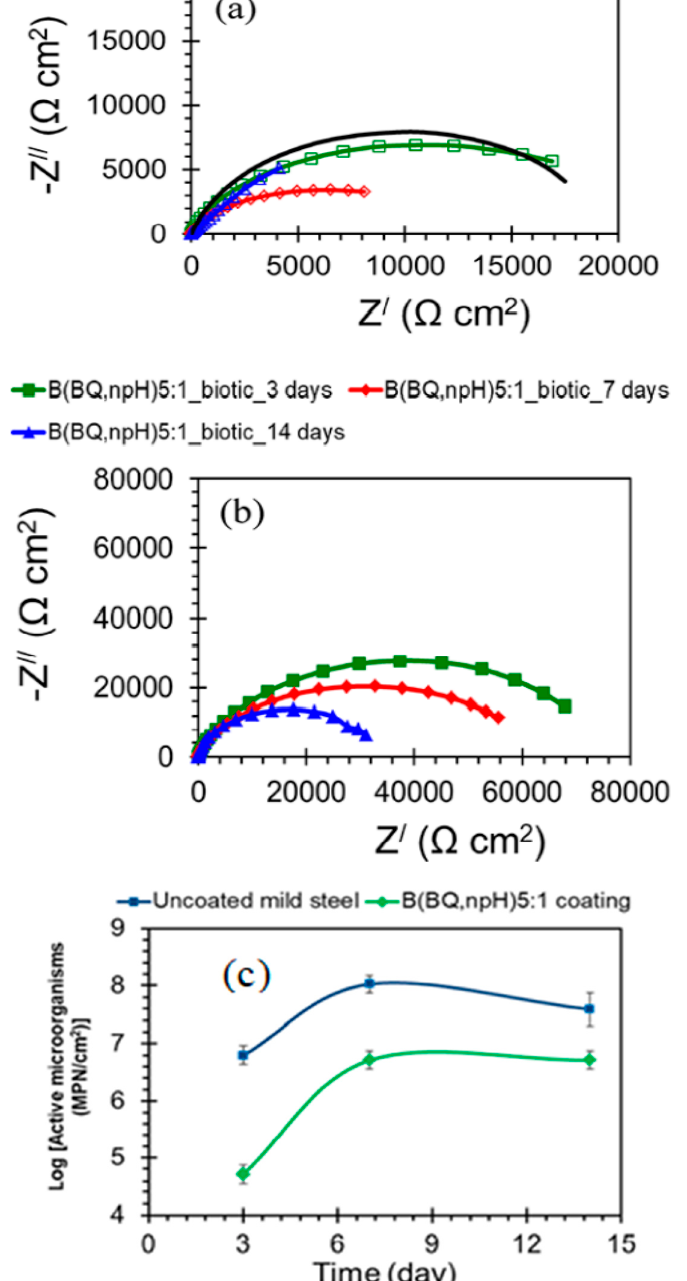
Figure 13. ( a , b ) Nyquist plots of uncoated and silane-coated mild steel after exposure times of 3, 7 and 14 days in a marine environment inoculated with SRB. ( c ) SRB population on uncoated and two-step silane-coated mild steel surfaces with respect to the time of exposure to the marine environment with SRB [93].